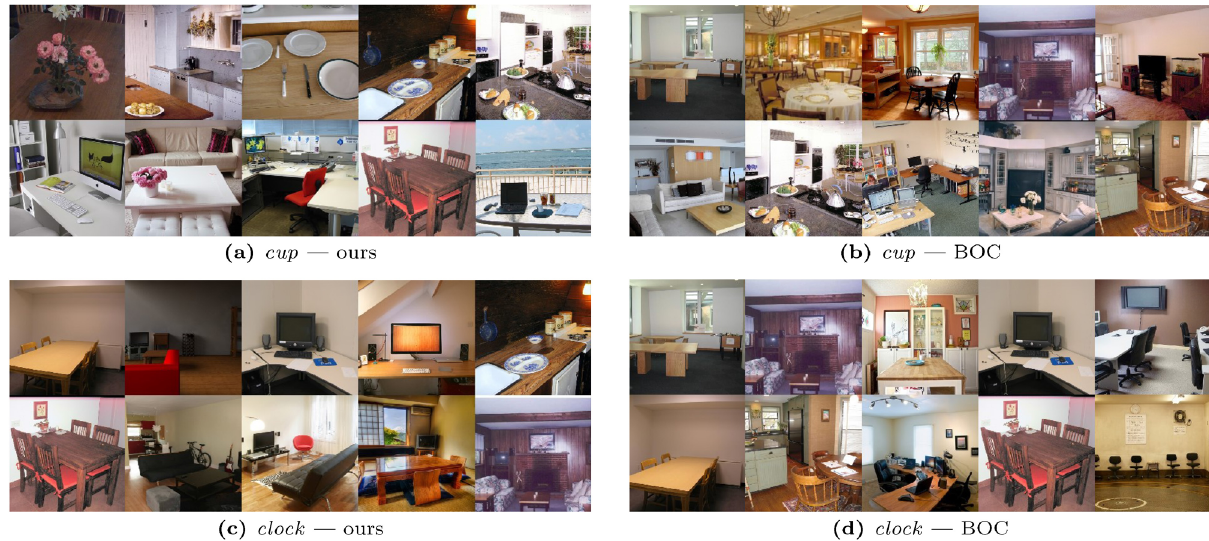
Fig. 5 Qualitative comparison of the 10 most highly recommended